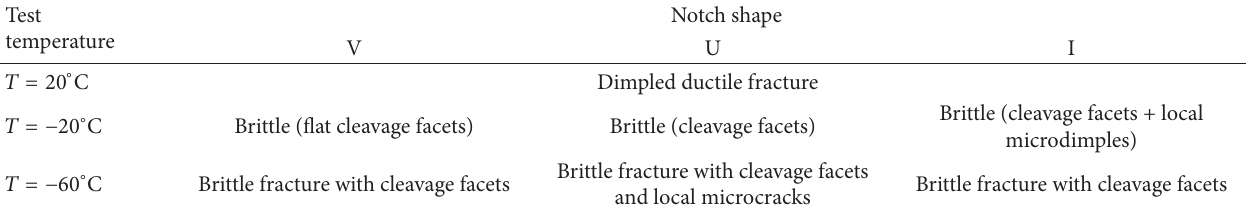
Table 6: Fracture micromechanisms in the crack propagation zone for specimens with different-shaped